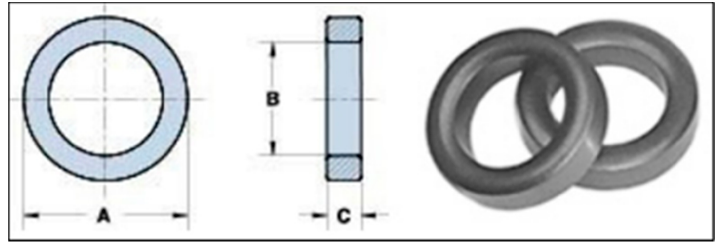
Figure 2. Ferrite 77 material core dimensions (courtesy: Fair-Rite products Corp). Table 1. Ferrite 77 toroid core dimensions (courtesy: Fair-Rite products Corp).